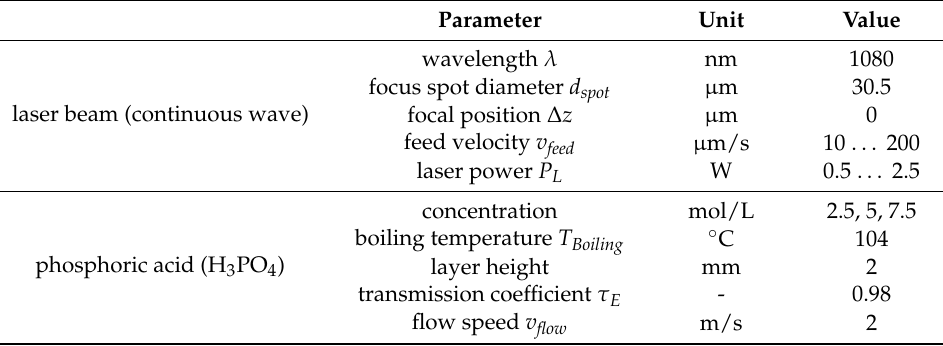
Table 1. List of process parameters used for experimental investigation.